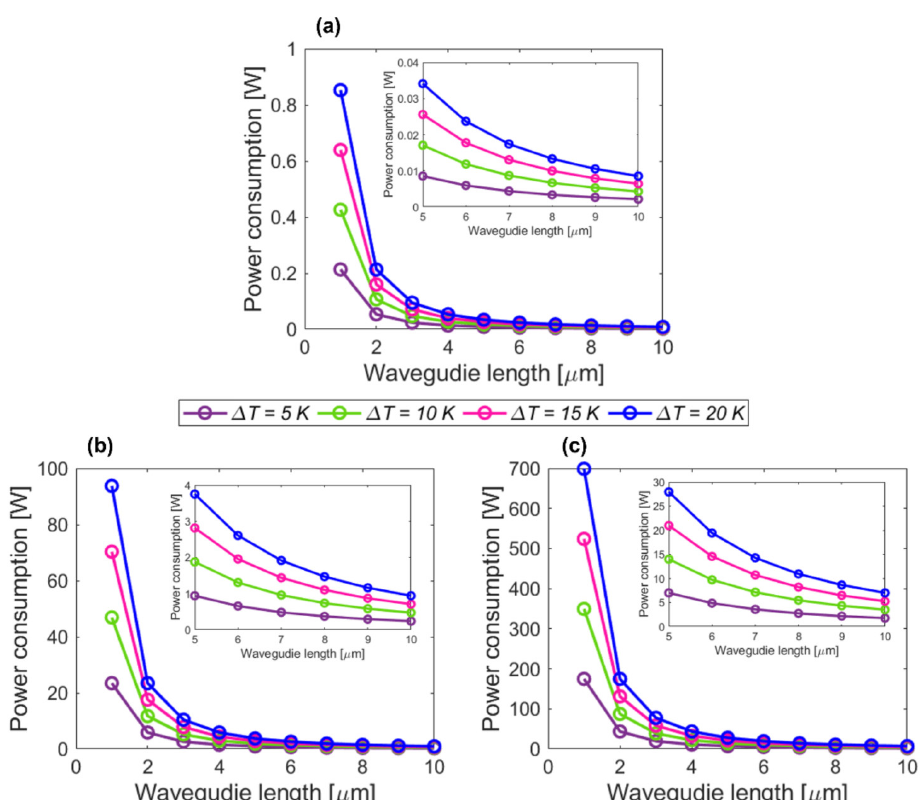
Figure 9. Power consumption analysis versus varied waveguide lengths to implement thermo-optic phase shifters, with a temperature changes Δ T in the 5 K to 20 K range. ( a ) Single thermo-optic phase shifter; circular OPA designs with ( b ) 110 and ( c ) 820 elements, respectively.